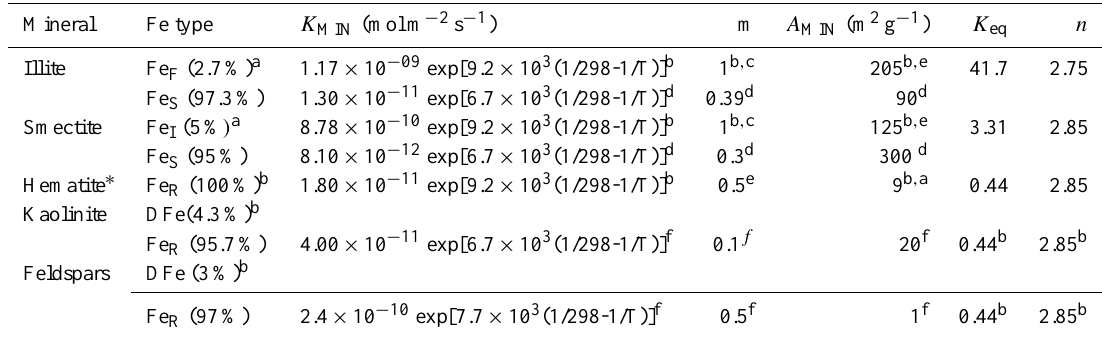
Table 2. Constants used for proton-promoted iron dissolution rates and emissions calculations for different types of iron-containing minerals: water-soluble/dissolved iron (DFe); fast-released iron (Fe F ); intermediate-released iron (Fe I ); slowly released iron (Fe S ); refractory iron (Fe R ). The parentheses contain the percentage content of Fe type in each mineral.